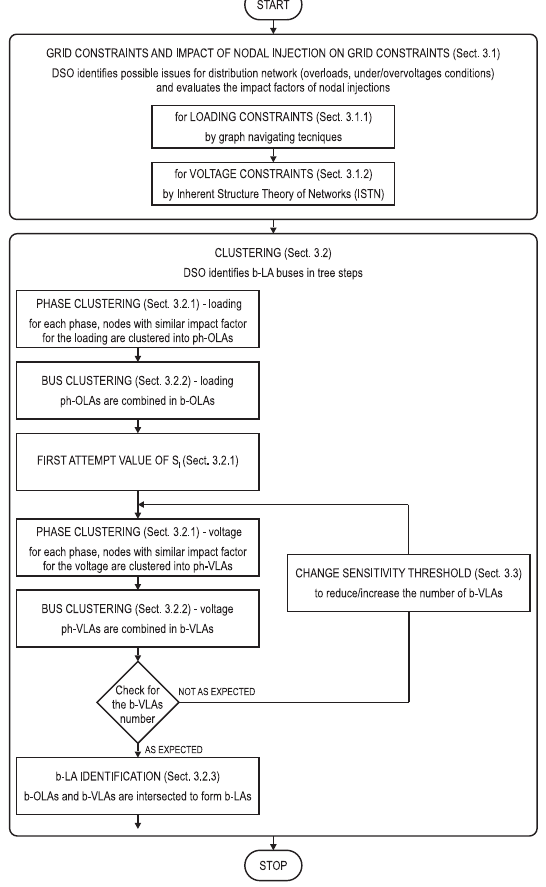
Figure 2. Functional block diagram to obtain